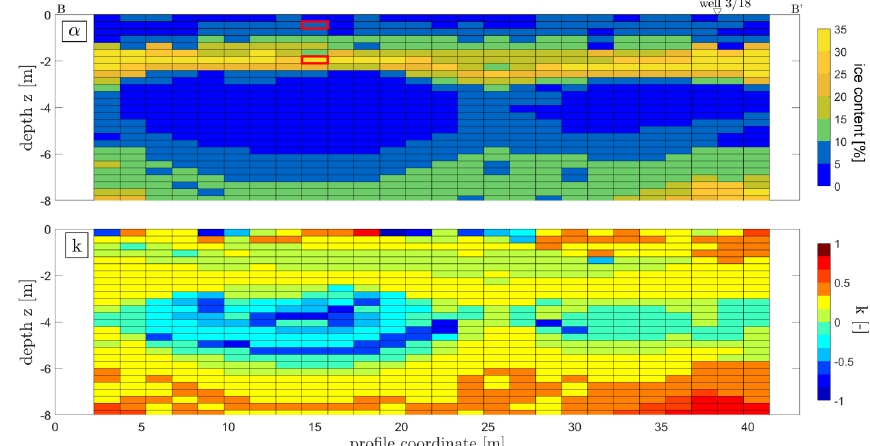
Figure 11. Two-dimensional sections of the percentage ice content α and the parameter k , calculated from the model after Zorin and Ageev (2017) using the procedure described in Sect. 3. The displayed section is the same as in Fig. 9 (B to B (cid:48) ). The two cells outlined in red in the upper section indicate the corresponding location of the spectra in Fig. 12.